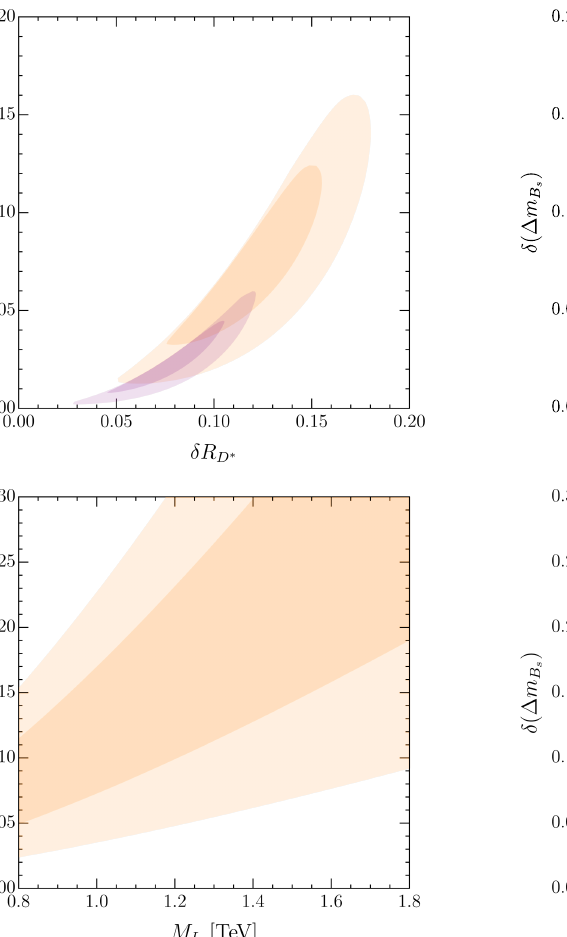
Figure 11 . Upper left: 1 σ and 2 σ regions in the ( δR D ∗ , δ (∆ m B energy fit, with Λ model for different values of M and 2 σ regions for δ (∆ m other plots, orange and purple correspond to the benchmarks β bτ